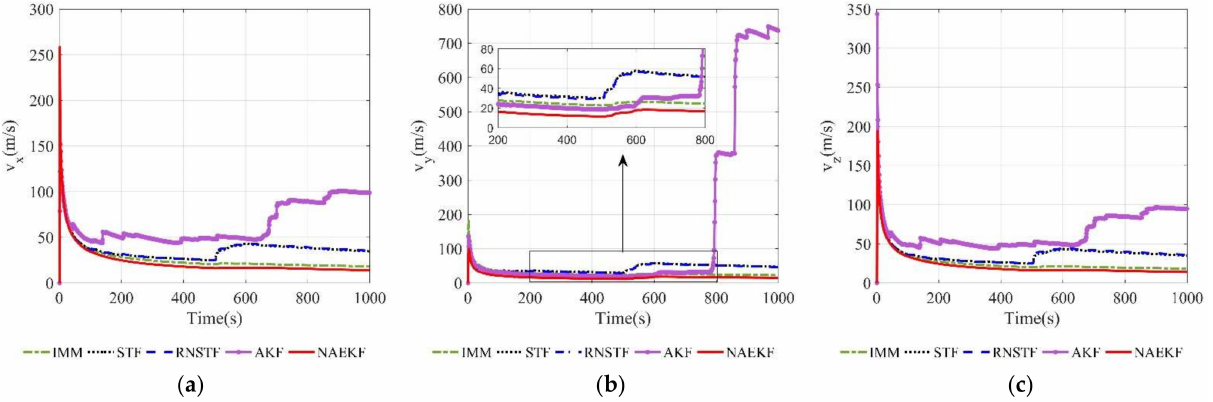
Figure 9. σ -Boundary of velocity estimation errors. ( a ) σ -Boundary of v x ; ( b ) σ -Boundary of v y ; ( c ) σ -Boundary of v z